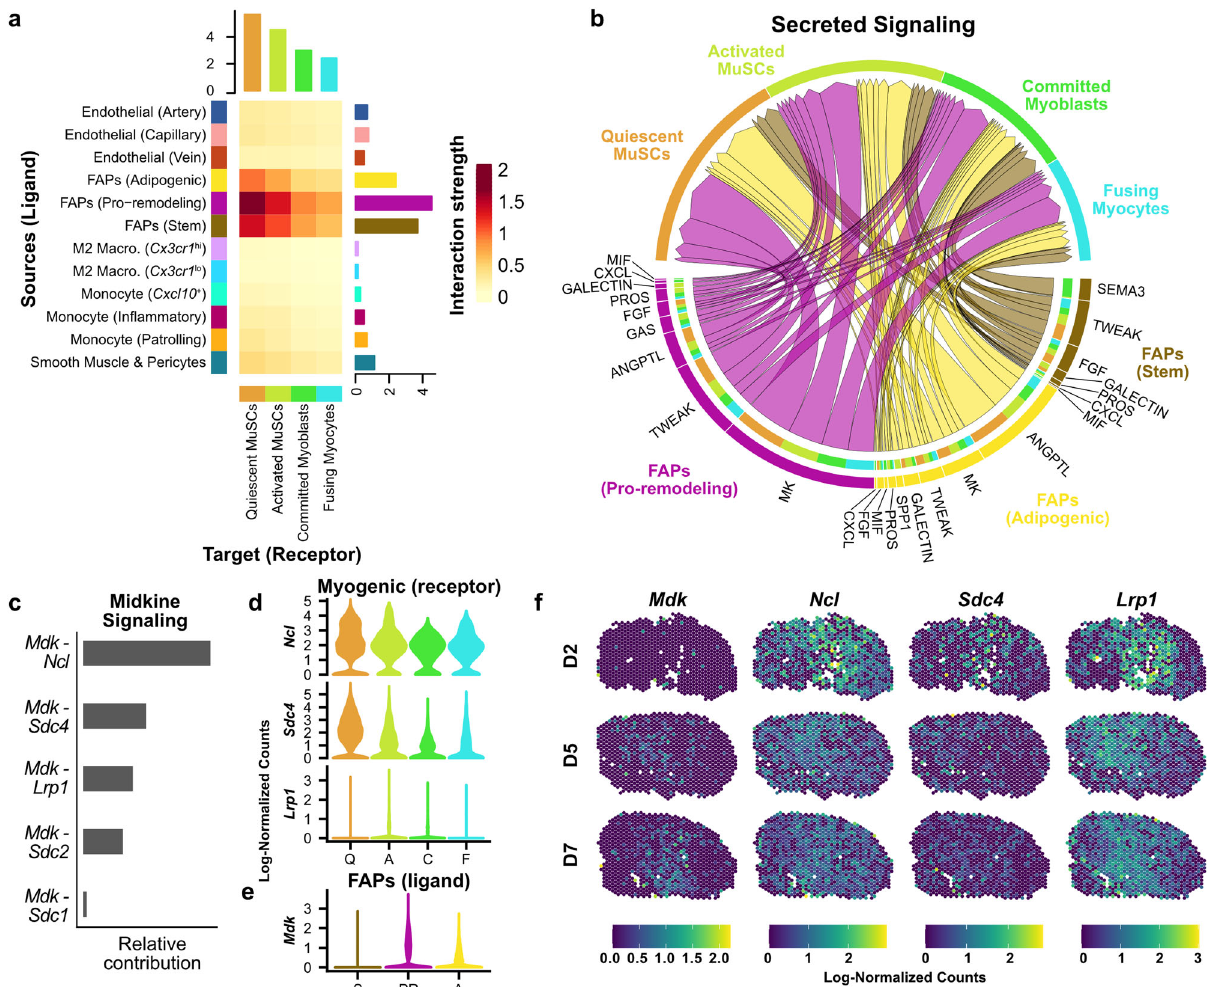
Fig. 5 Integrated ligand-receptor analysis in sc/snRNAseq data compendium informs colocalized communication analysis in spatial transcriptomics data. a Predicted ensemble ligand-receptor interactions strengths between endothelial, FAP, myeloid, smooth muscle (ligand-expressing), and myogenic (receptor-expressing) cell types using CellChat. b Chord plot showing the signi fi cant pathways annotated as “ Secreted Signaling ” between FAP and myogenic sub-populations, as assessed by CellChat (see “ Methods ” ). Chords point from the FAP ligand source (protein name abbreviations listed; MK, midkine) to the myogenic cell sub-population expressing its partner receptor (names not listed). The width of the chords shows the interaction strength. c Relative interaction strengths of speci fi c Midkine ligand-receptor pairs summed across all FAP and myogenic populations. d Log-normalized expression of the receptor and e ligand gene transcripts are shown for the sc/snRNAseq data compendium, for the four myogenic cell types, and the three FAP cell types, respectively. f Log-normalized expression of Midkine signaling factors in spatial RNAseq data (at 2, 5, and 7